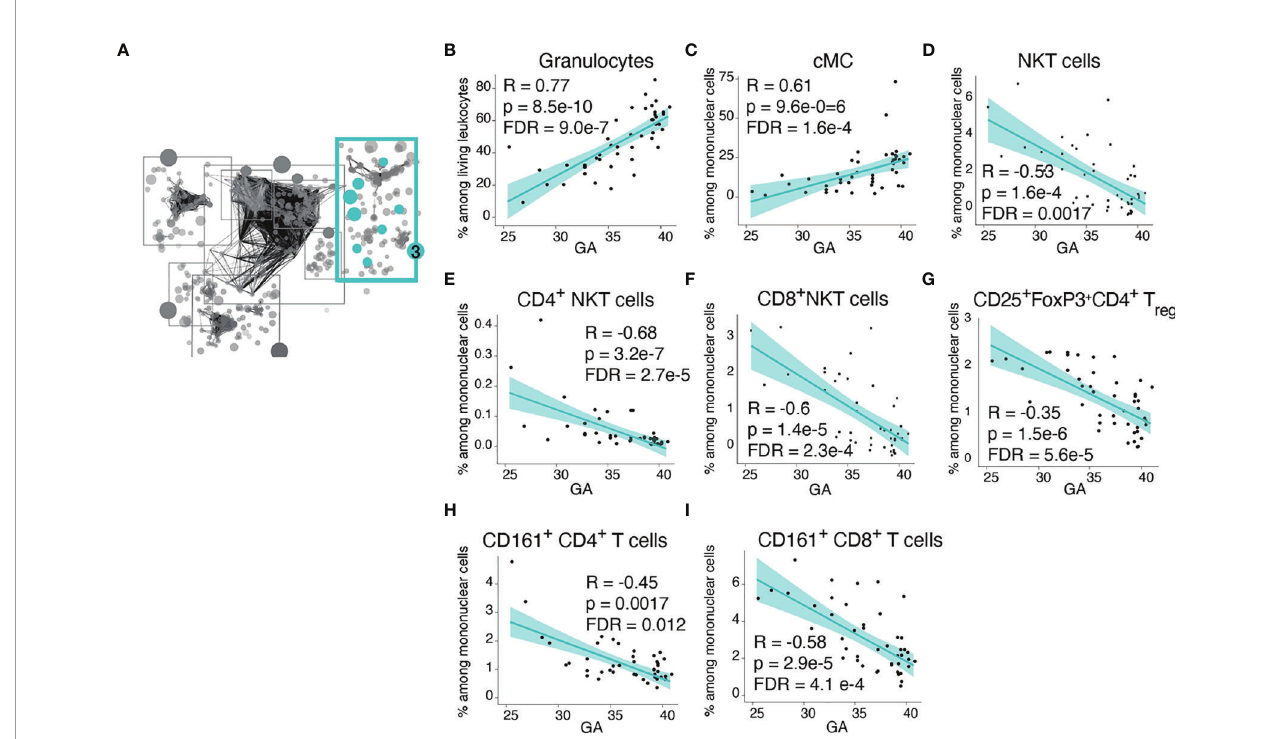
FIGURE 4 | Advancing GA is associated increasing frequency of key defensive innate immune cells and with decreasing frequency of invariant and regulatory T cell subsets. (A) Community 3 contained 164 informative immune features (164 nodes), including frequencies innate and adaptive immune cell subsets. (B – I) Relationship between GA and highlighted features in community 3. The frequency of granulocytes and cMCs increased with GA, while the frequency of NKT-like cells, T reg cells, and CD161-expressing CD4 + and CD8 + T cells decreased with GA. Spearman